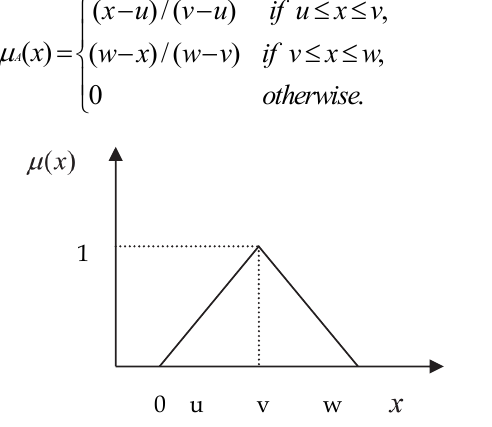
Fig. 2. Triangular fuzzy number membership